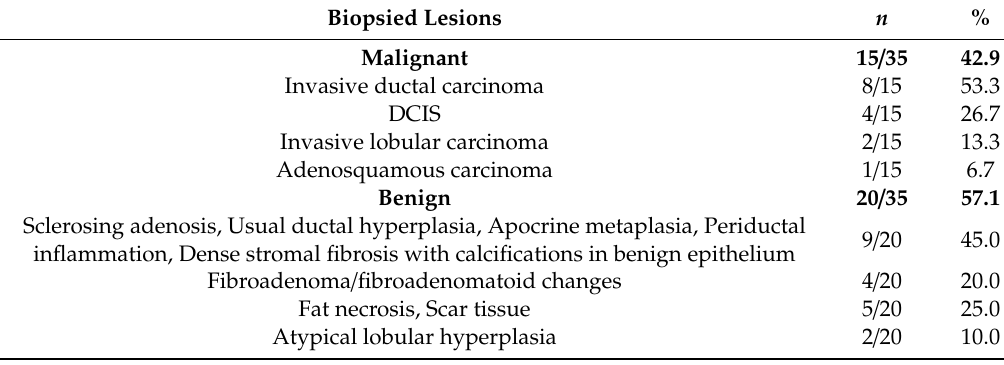
Table 2. Histologic characteristics of the biopsied lesions. Interval cancers are not included in this table. DCIS: ductal carcinoma in